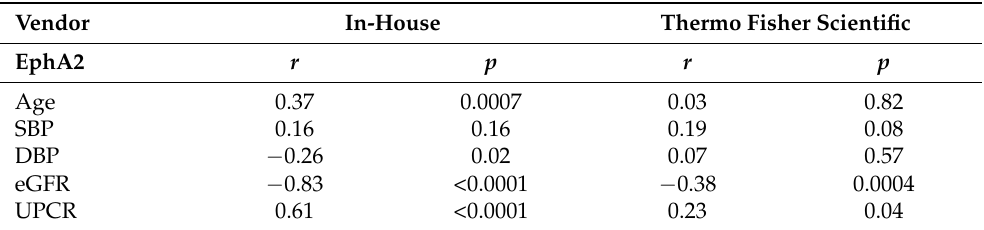
Table 2. Spearman’s rank-order correlation between serum EphA2 concentrations and various clinical parameters in patients.